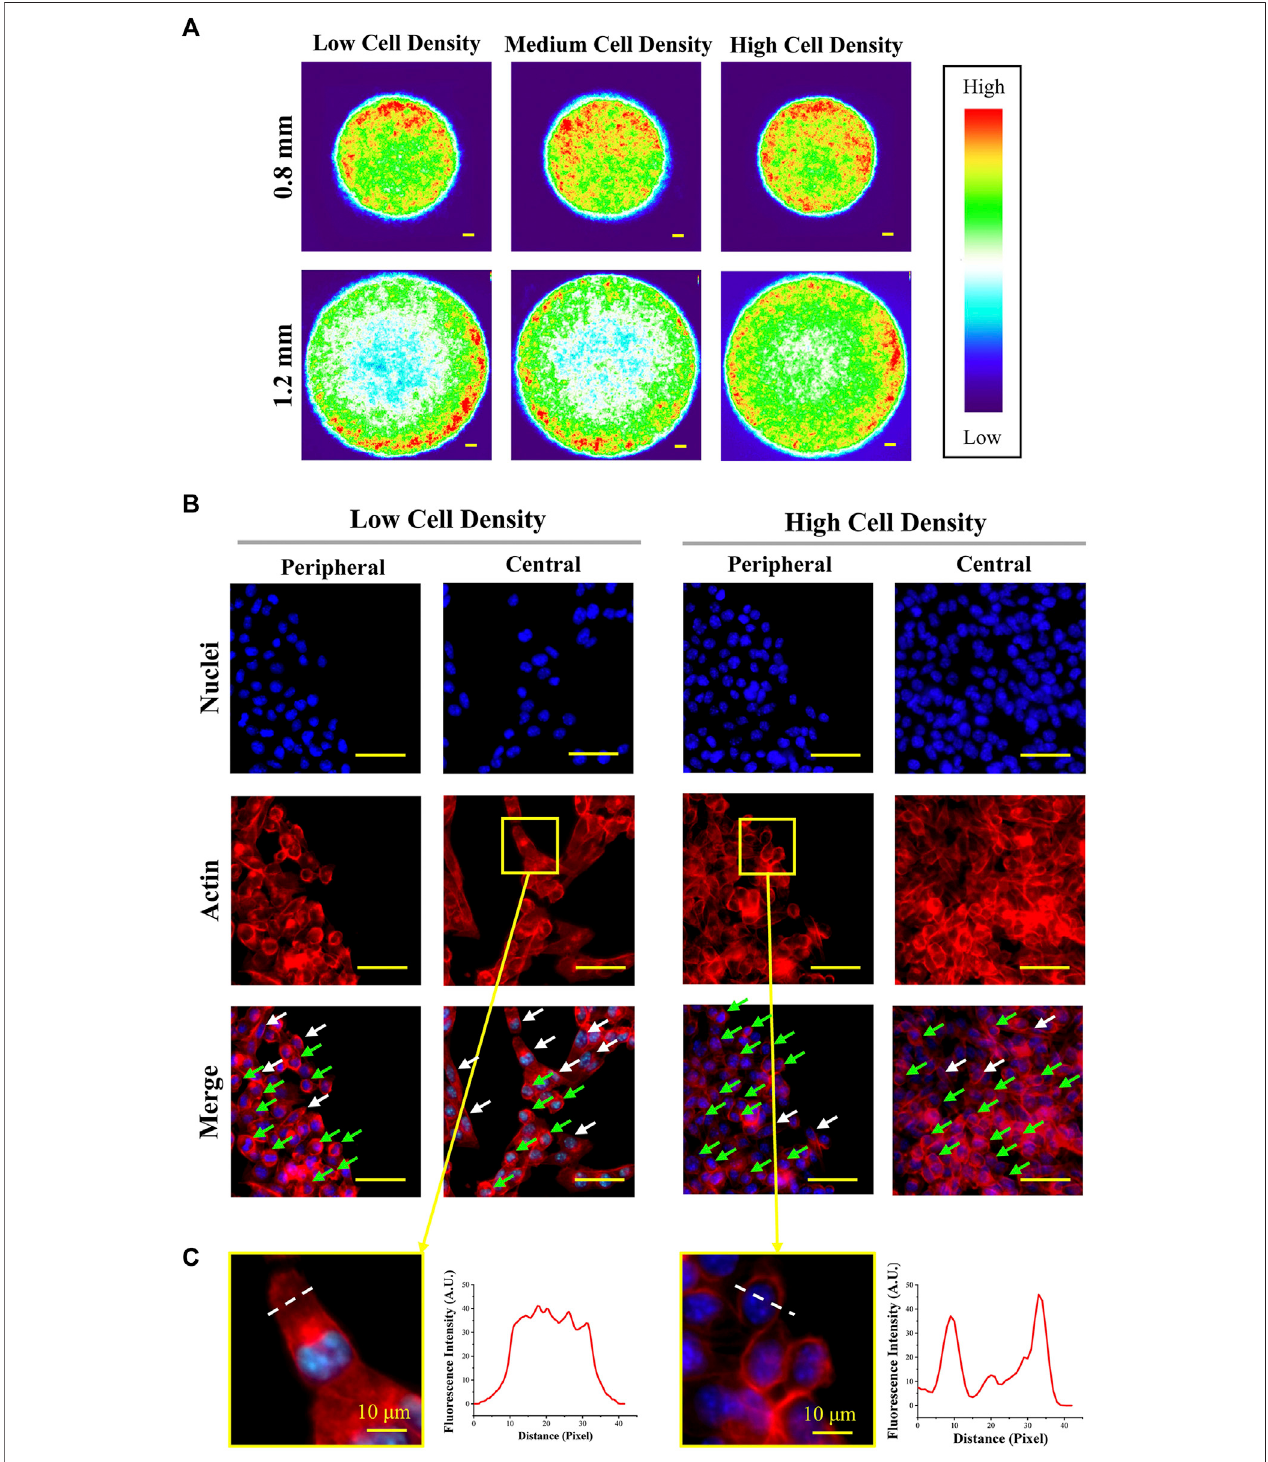
FIGURE 5 | Structure of actin at the peripheral and central regions of colonies. (A) Heat maps of actin-stained fl uorescent images. Scale bar: 50 μ m. (B) Representativemagni fi ed fl uorescentimages ofstainednucleiandactin ( d =1.2 mm).Scalebar:50 μ m. (C) Representativeimages and fl uorescenceintensitycurvesof spindle-shaped and circular-shaped melanoma cells ( d = 1.2 mm). Scale bar: 10 μ m.